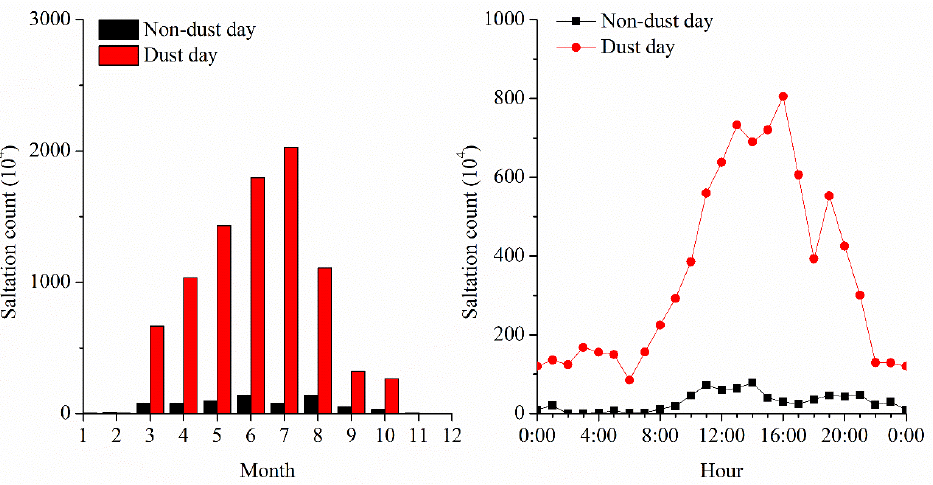
Figure 8. Monthly and diurnal variations in the saltation counts on dust and non-dust days.